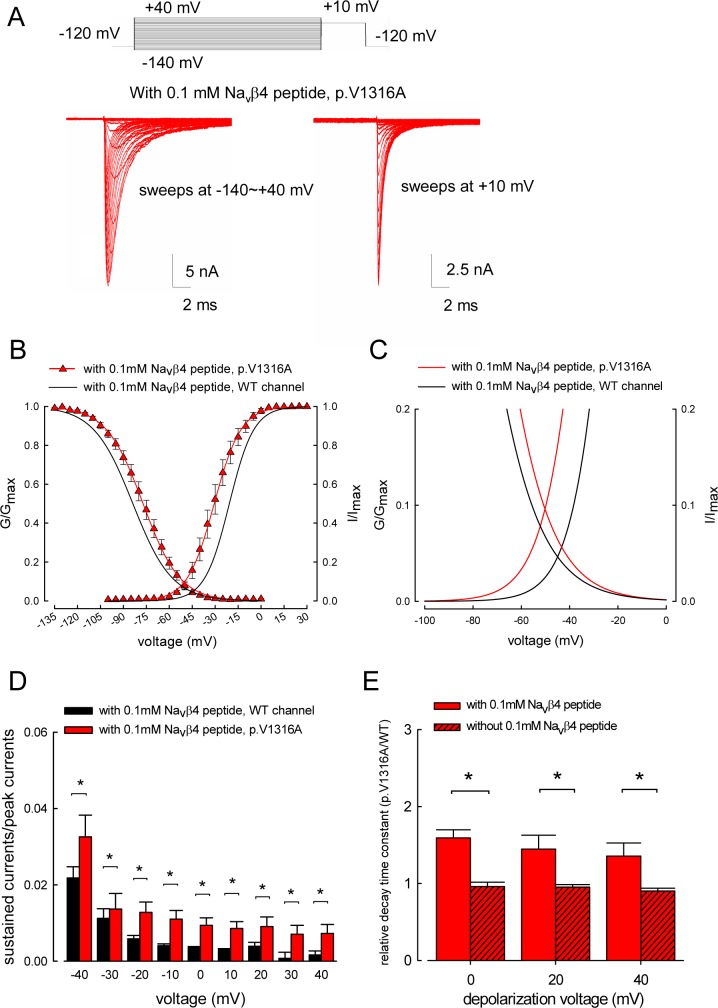
The activation and inactivation curves of the p.V1316A mutant channel in the presence of the Navβ4 peptide.(A) Sample sweeps for the making of the activation (left panel, currents during the –140 to +40 mV prepulse) and inactivation (right panel, currents during the +10 mV pulse following the prepulse) curves of the p.V1316A mutant channel in the presence of the Navβ4 peptide are shown (see Materials and Methods for the experimental protocols). (B) The activation and inactivation curves for each cell are also fitted with Boltzmann functions, and the cumulative results for Vh and k are –30.48±2.45 mV (n = 12; p < 0.05, versus WT channel) and 8.05±0.51 (n = 12; no significant difference versus WT channel) for the activation curves, respectively. For the inactivation curves, Vh and k are –77.04±2.17 mV (n = 12; p < 0.05, versus WT channel) and –10.9±0.39 (n = 12; no significant difference versus WT channel) in the p.V1316A mutant channel, respectively. Single Boltzmann fits to the mean values are for the p.V1316A mutant channel: Vh and k are ~–30.7 mV and ~8.7; for the activation curve; Vh and k are ~–77.1 mV and ~12.0 for the inactivation curve. The solid black lines for the WT channel are taken from Fig 2B for comparison. (C) A closer view of the fitting lines in part B between –100 and 0 mV. (D) Cumulative results were obtained with the same protocols described in part A for the WT and p.V1316A mutant channels (n = 15 for the WT channels; n = 12 for the p.V1316A mutant channels). The ratio between the sustained and peak transient currents (in the same sweep) is significantly larger in the p.V1316A mutant channel with depolarization potentials between –40 and +40 mV. *, p < 0.05. (E) At each depolarization voltage (0, +20, and +40 mV), the time constants (tau) of the decay (inactivation) phase of transient Na+ currents in the p.V1316A mutant channel are normalized to the average time constants of the inactivation phase of transient Na+ currents in the WT channel to give the relative inactivation tau, either in the presence or absence of 0.1 mM Navβ4 peptide. The cumulative results (n = 10–12 for each measurement) show that the relative inactivation time constant at each depolarization voltage is significantly lengthened by the p.V1316A mutation only in the presence but not in the absence of the Navβ4 peptide. *, p < 0.05. Individual data is shown in the file of S1 Data.